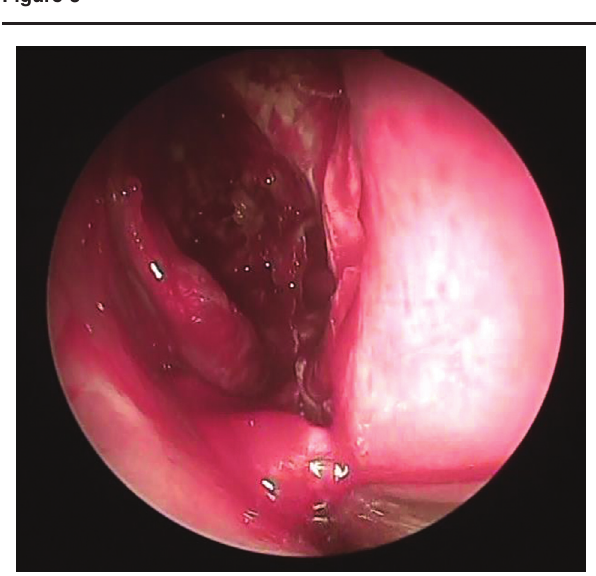
MMA and sphenoidotomy. Figure 3